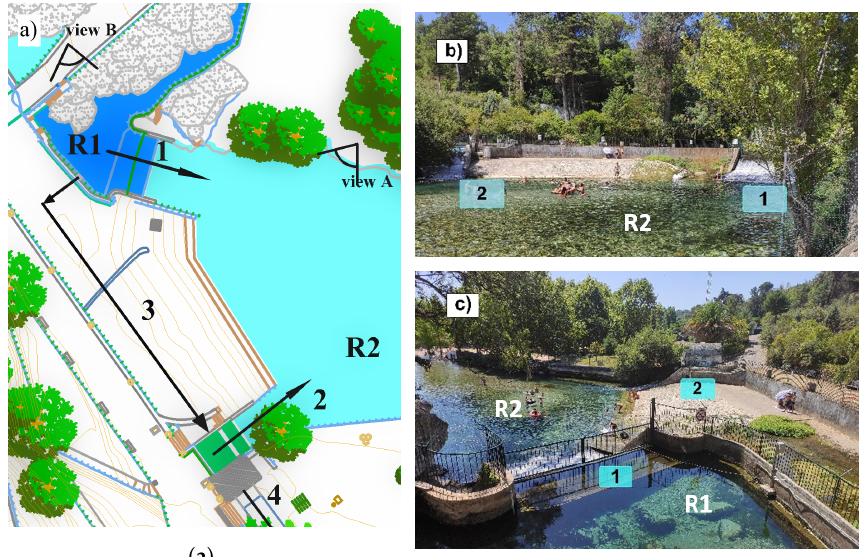
Figure 3. Alviela river source ( a ) catchments scheme; ( b ) view A and ( c ) view B (1—Weir 1; 2—Weir 2; 3—Pipe; 4—Alviela aqueduct inlet; R1-Upstream reservoir; R2-Downstream